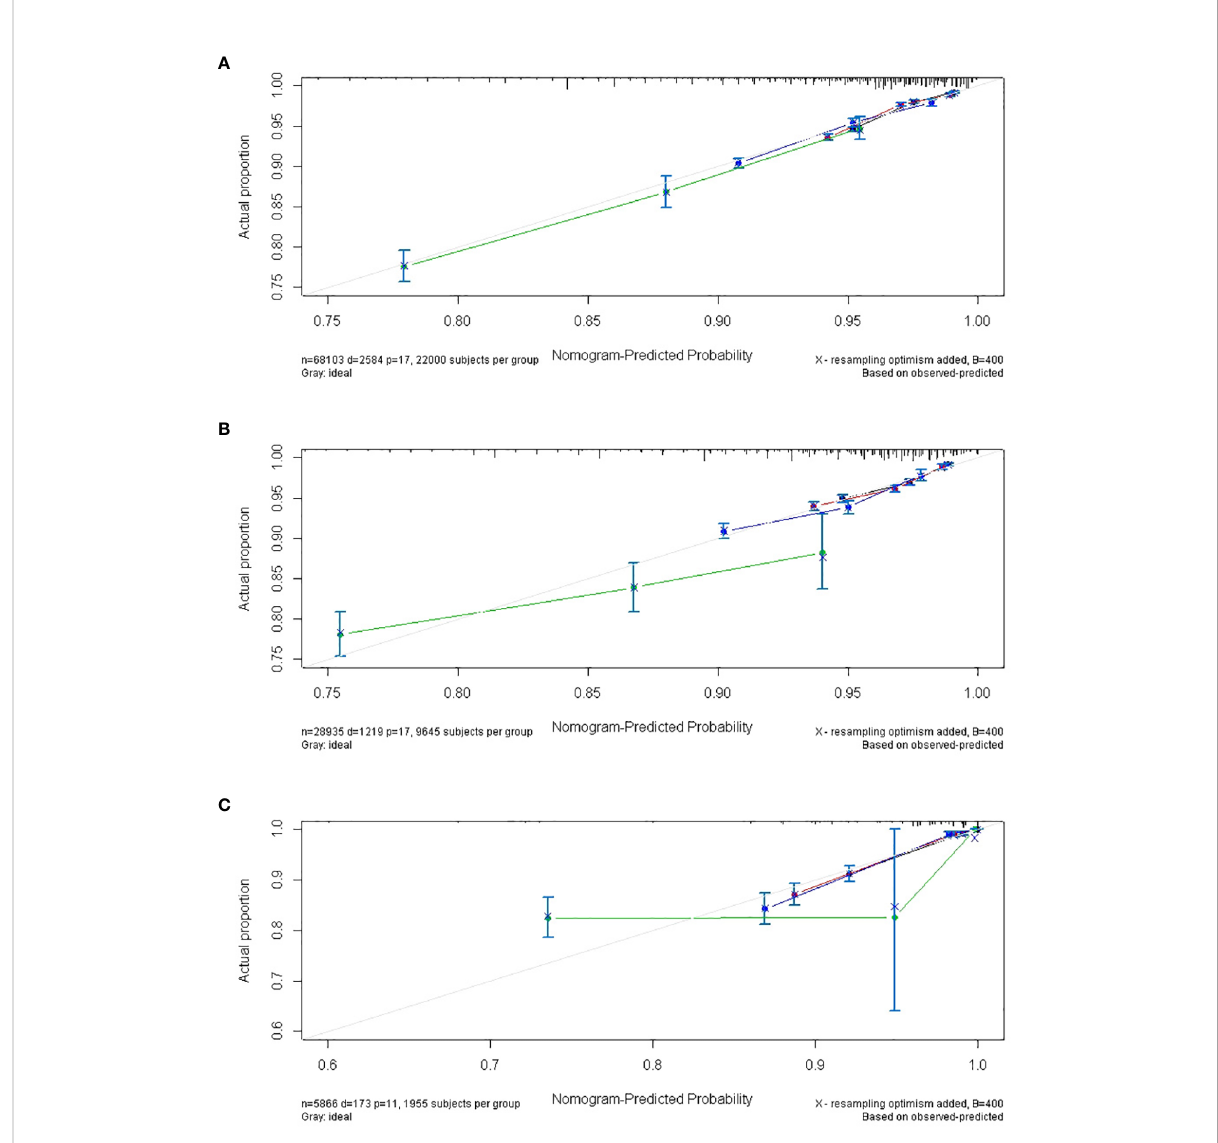
FIGURE 10 The calibrate curves of the nomogram of predicting the latency between cervical cancer and SPM. (A) trainset; (B) testset; (C) external test cohort. (black line: 5-year calibrate curve; red line: 10-year calibrate curve; blue line: 15-year calibrate curve; green line: 19-year calibrate